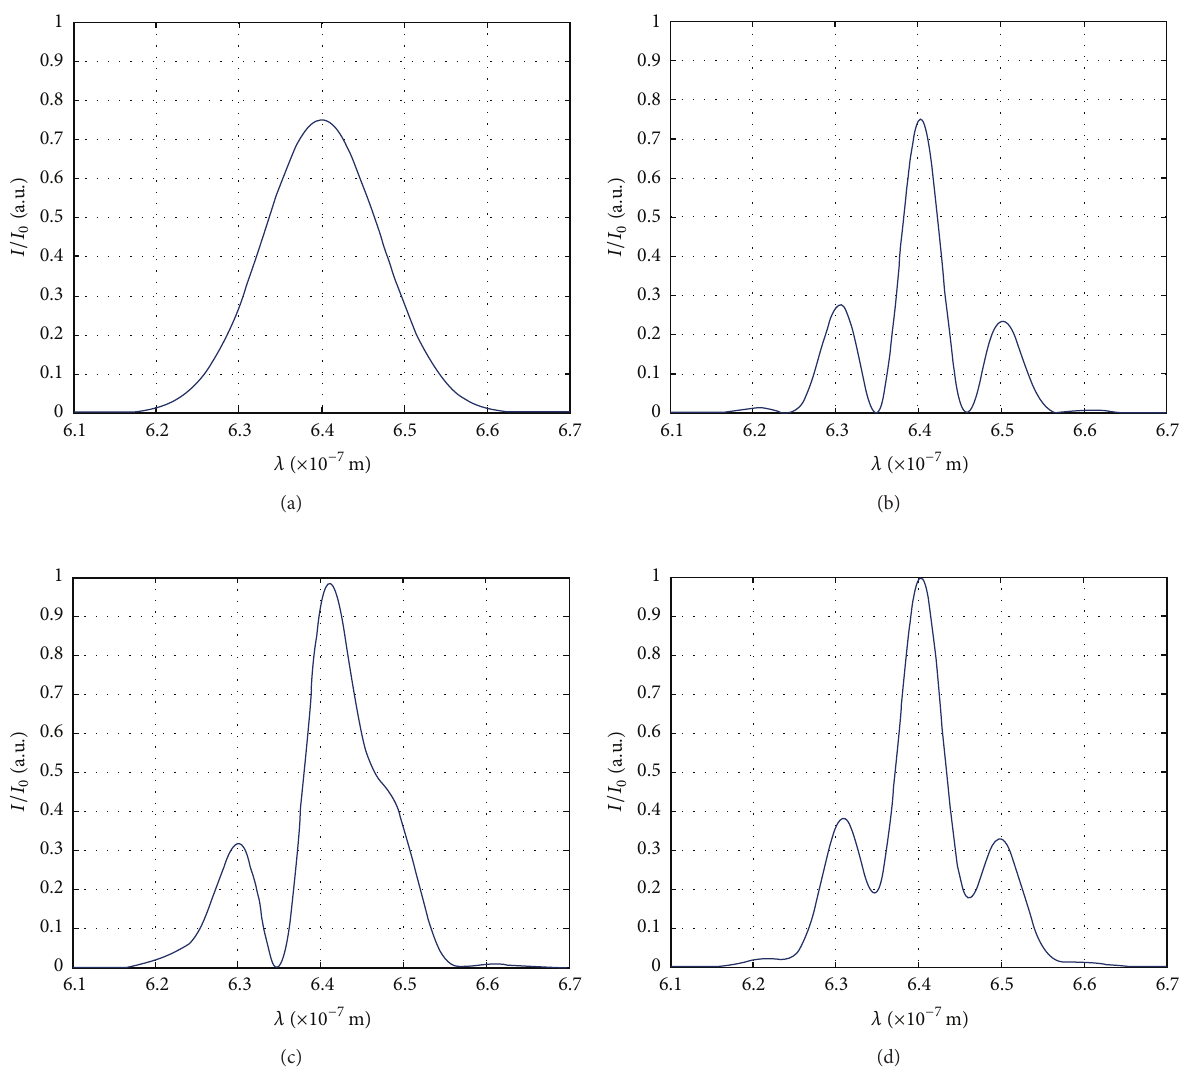
= 𝑑 = 2.127 mm; 𝛼 = 60 ∘ ; 1 2 = 𝑑 = 2.127 mm; 𝛼 = 30 ∘ ; 1 2 = 𝑑 = 2.127 mm; 1 2